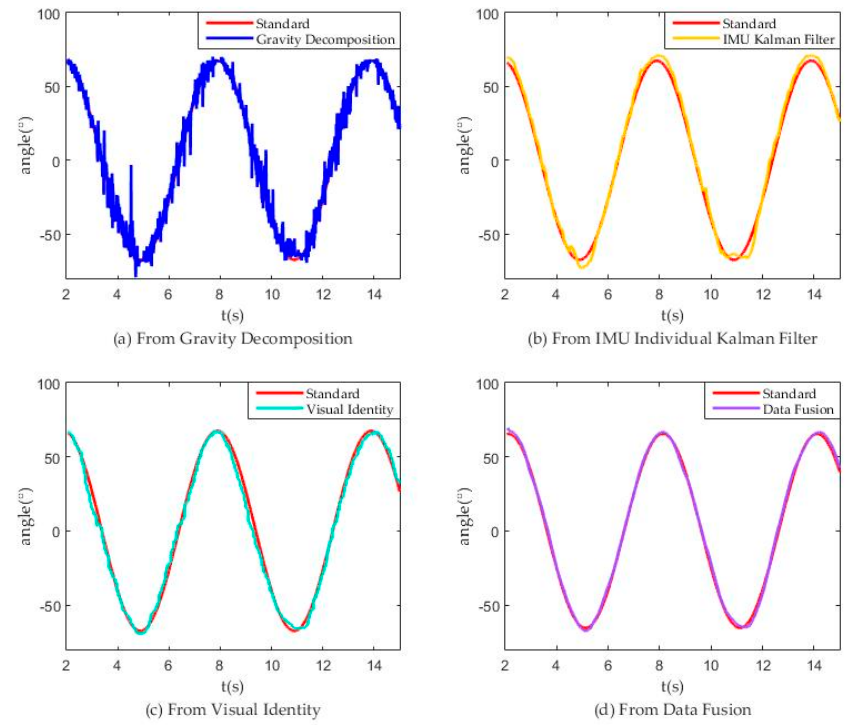
Figure 10. Model test data from different sources.